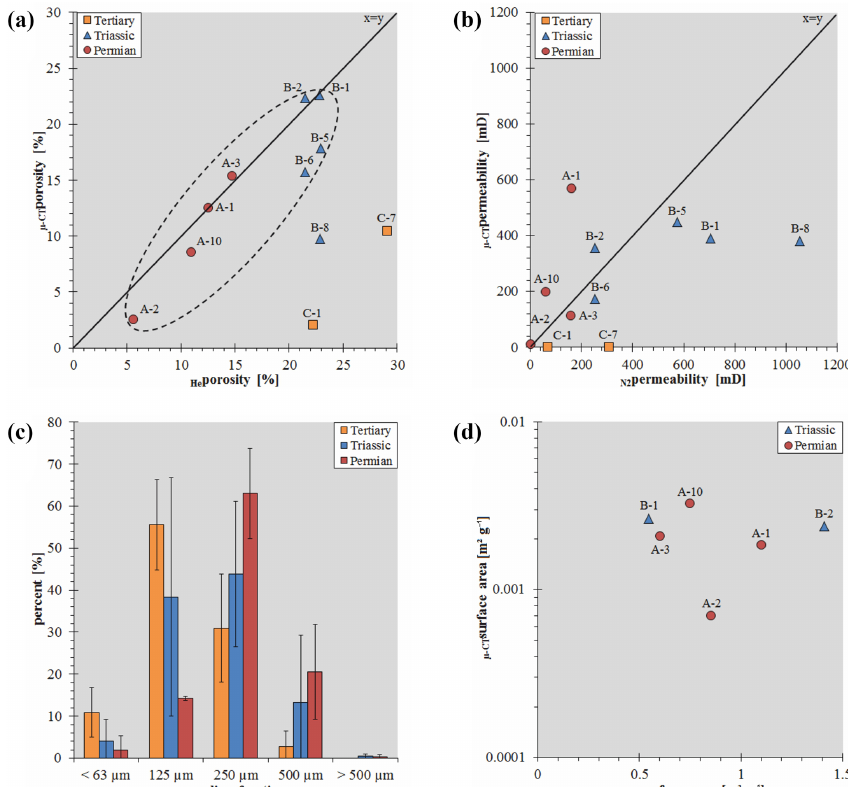
Figure 5. In (a) the porosity results of the same eleven µ -CT and He-porosity analysed samples are shown for the three different stratigraphic units. The ellipse marks the sandstone samples with coarse sand (2.00–0.63mm) and medium sand (0.63–0.20mm) grain sizes. In (b) the permeability data of the same sample set as shown in (a) are presented. In (c) the mean grain fraction sizes (after Wentworth, 1922) analysed on thin section with the corresponding standard deviation of the 25 samples in this study are shown (cf. Table 2). In (d) the mean values of the specific surface area data from the BET and µ -CT methods are outlined for Permian and Triassic